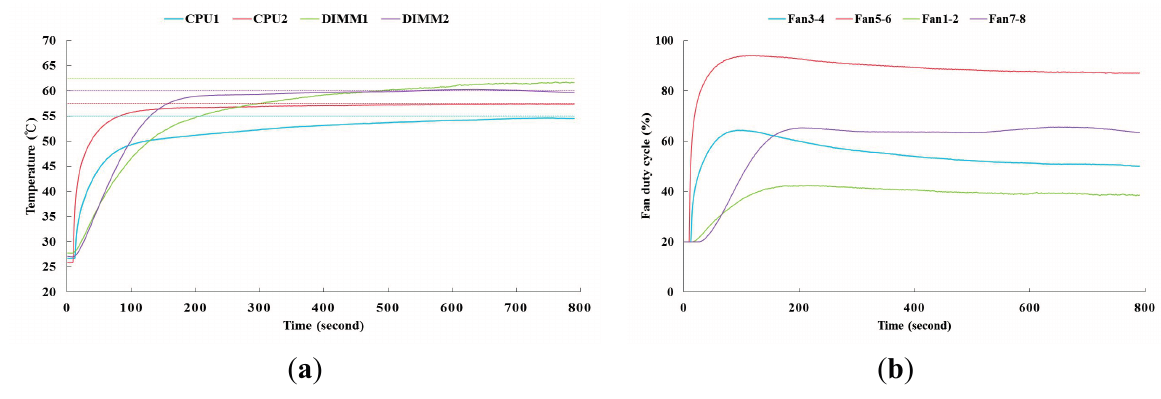
Figure 10. Control results of PID controllers without an overshoot. ( a ) The temperature responses of the electronic components by the PID controllers; ( b ) The control efforts of the fans by the PID